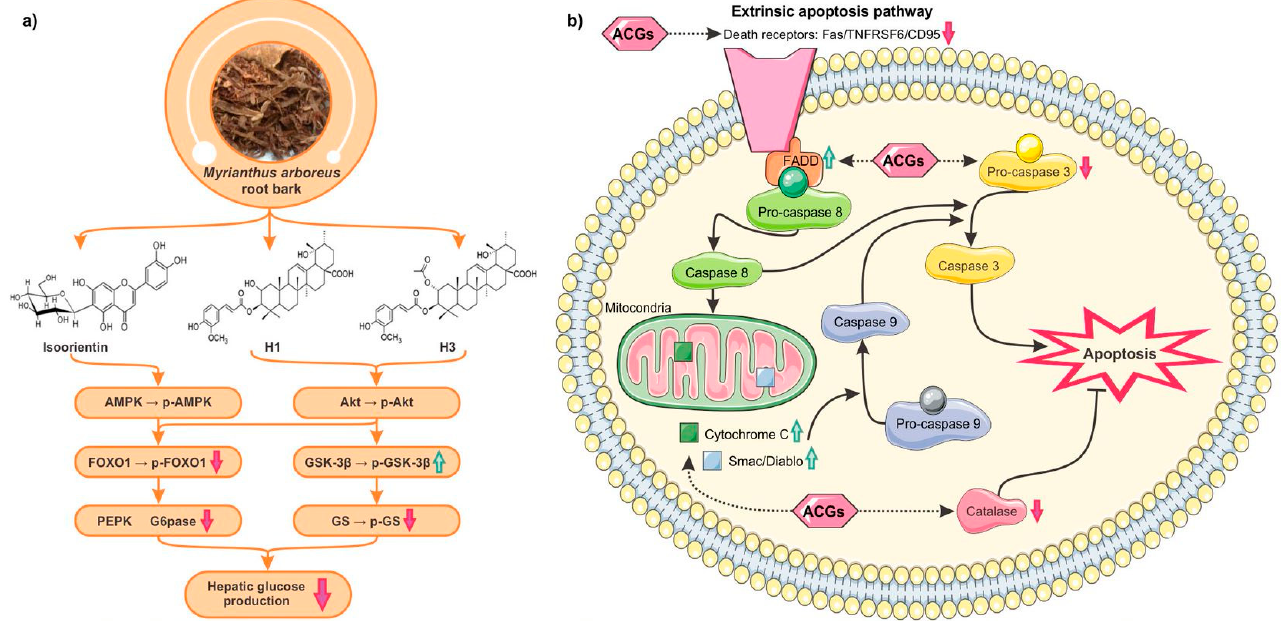
Figure 1. Mechanism of action of bioactive compounds from Myriantus arboreus root bark ( a ) and Acer rubrum bud ( b ) extracts according to in vitro experiments. ( a ) Compounds isolated from M. arboreous root bark, namely isoorientin, 3 β - O - trans -feruloyl-2 α ,19 α -dihydroxyurs-12-en-28-oic acid (H1) and 2 α -acetoxy-3 β - O - trans -feruloyl-19 α -hydroxyurs-12-en-28-oic acid (H3), were determined to decrease the activity of hepatocyte glucose-6-phosphatase (G6pase) by increasing AMPK phosphorylation and to stimulate glycogen synthase (GS). This action led to the reduction of hepatic glucose production and the enhancement of glucose storage [44,45]. ( b ) Delayed death of neutrophils in tissues can cause an unwanted and exaggerated inflammatory reaction. Anhydroglucitol-core gallotannins (ACGs) from A. rubrum buds modulate the viability of human blood neutrophils. The significant increase of FADD, an adaptor protein that bridges proteins containing death receptors associated with a significant reduction of Fas/TNFRSF6/CD95 expression, suggests the implication of the extrinsic pathways in the induction of neutrophil apoptosis by ACGs. Neutrophils treated with ACGs showed a significant rise of SMAC/Diablo and cytochrome C, two caspase-dependent proteins released from mitochondria, thereby affecting the apoptotic process of human neutrophils